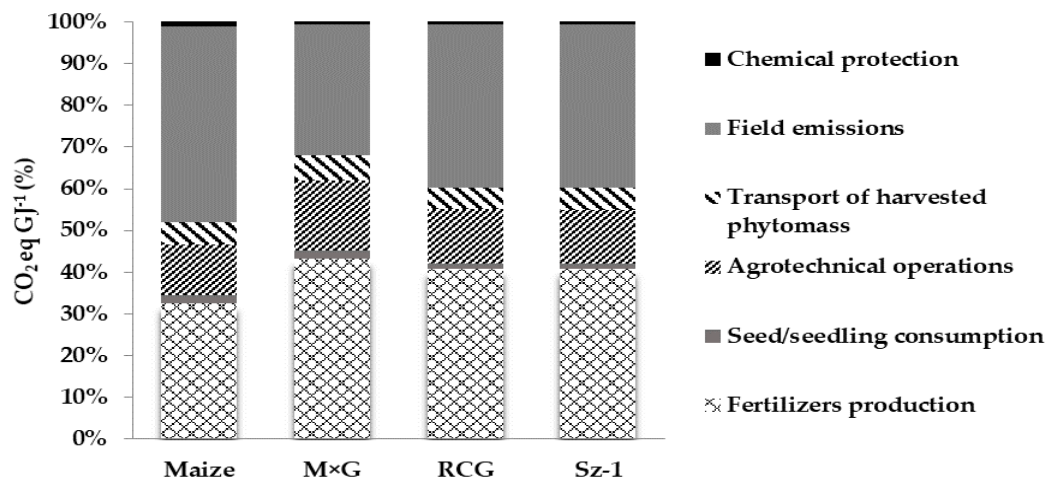
Figure 1. Contributions of every process to the total environmental burden (%).Identical contribution of RCG and Sz-1 and every process to the total environmental burden (%) is caused by identical farming technology used.